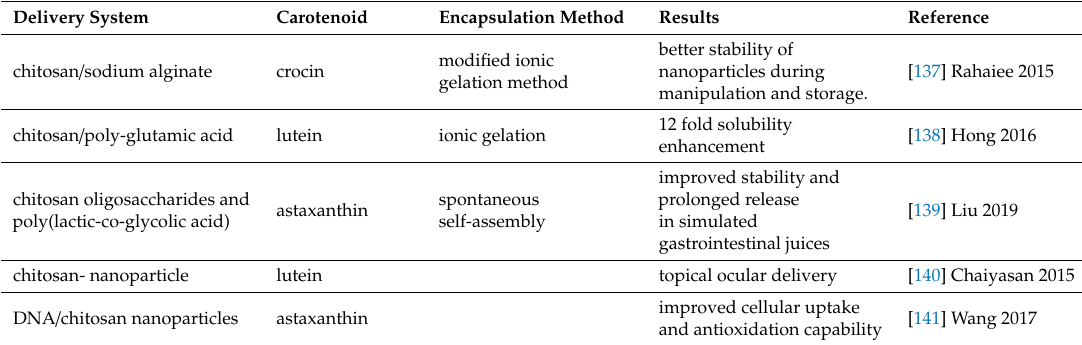
Table 7. Polymeric nanoparticles as delivery system for carotenoid encapsulation: chitosan